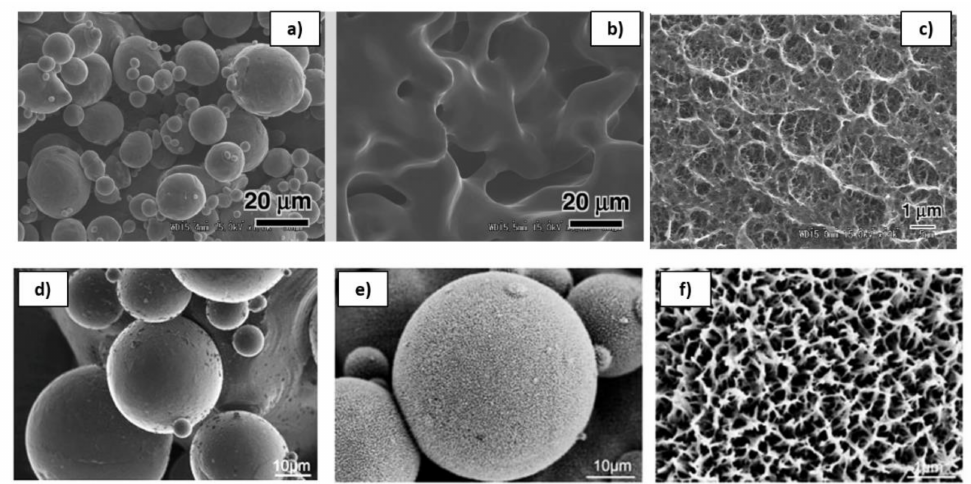
Figure 2. Surface morphology of bare and surface treated AM Ti-based materials. ( a ) Unmelted particles on SLM Ti; ( b ) thermally treated (1300 ◦ C) SLM Ti with disappearance of unmelted particles, and ( c ) nanotexture on SLM Ti after high temperature thermal treatment, chemical, and heat treatment, reprinted from [23] with Elsevier’s permission; ( d ) unmelted particles on the surface of SLM Ti with bulbous-stripy structure, ( e ) detail of the microtopography, and ( f ) nanotexture obtained by hydrothermal treatment, reprinted from